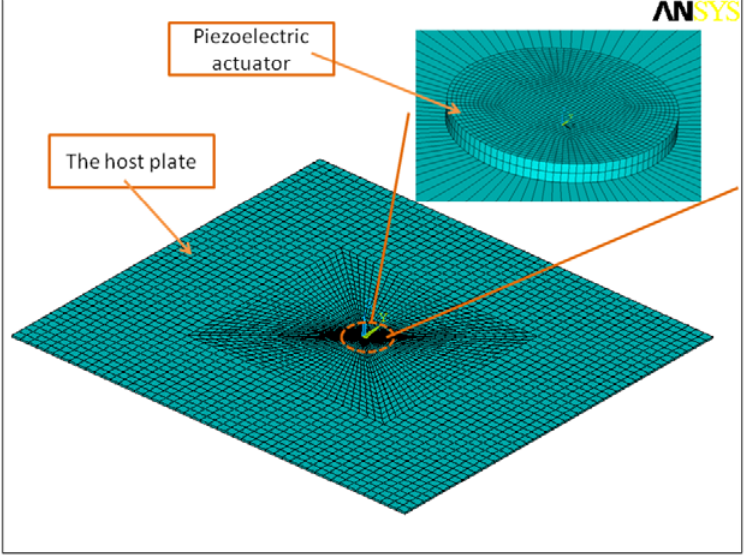
Figure 8. FE modeling and meshing of a circular piezo-actuator bonded to a host plate.